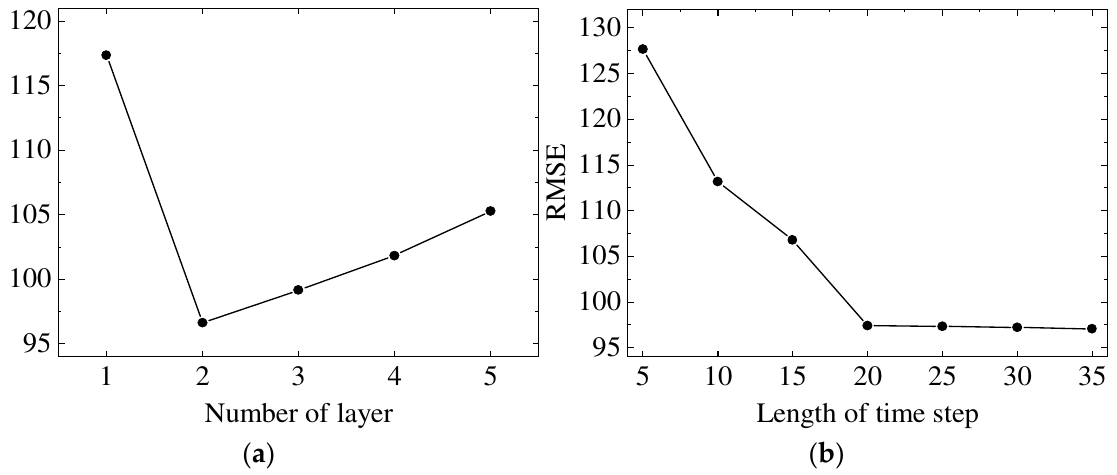
Figure 20. Test result error curves. ( a ) Description of RMSE of test results under different layers; ( b ) description of RMSE of test results under different time steps.